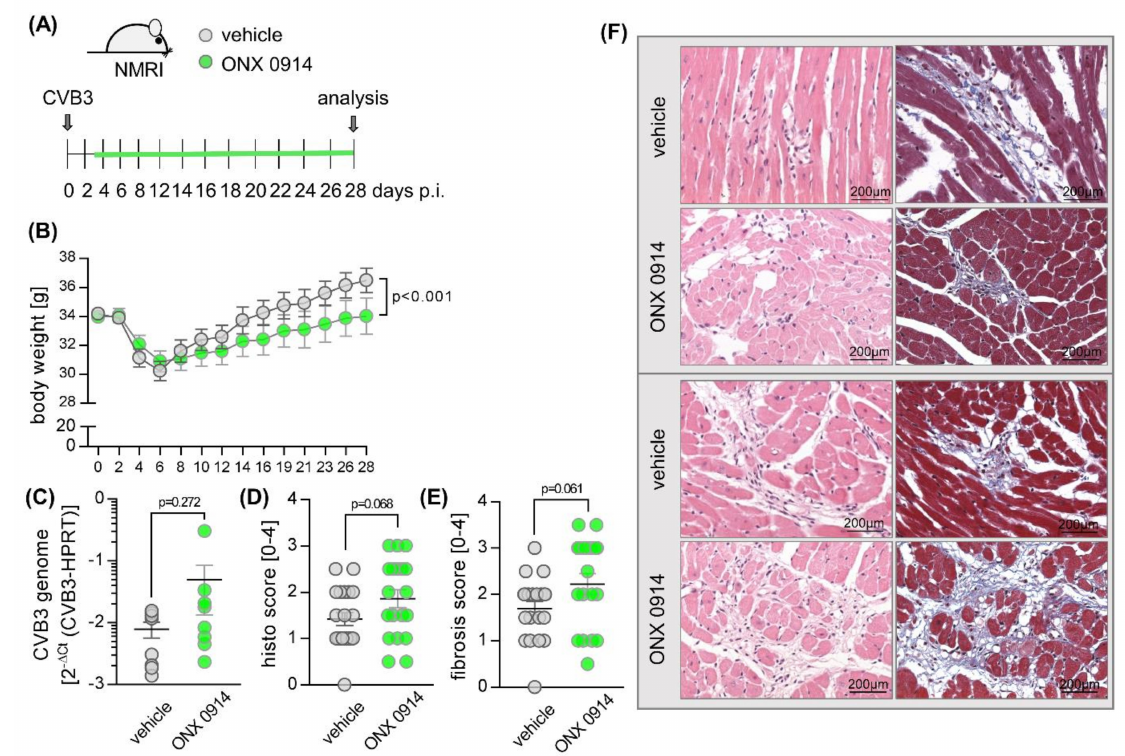
Figure 1. E ff ect of ONX 0914 on the manifestation of chronic viral myocarditis in NMRI mice. ( A ) Mice were inoculated with 5 × 10 5 pfu of Coxsackievirus B3 strain 31-1-93. Between days 3 and 8, mice were treated with ONX 0914 (5–10 mg / kg) or vehicle (Captisol) daily—thereafter treatment continued three times per week until day 28 (vehicle n = 20; ONX 0914 n = 20). ( B ) Body weight was monitored as indicated and analyzed using two-way ANOVA. ( C ) Mice were sacrificed after 28 days. RNA was extracted from heart tissue and Coxsackievirus B3 (CVB3) genome expression was determined by quantitative PCR. Para ffi n-embedded, hematoxylin-eosin ( D ) and Masson’s trichrome-stained cardiac tissue ( E ) was taken for histological scoring of cardiac injury and inflammation. ( F ) Two representative images (upper panel from the group treated with 5–7 mg / kg bodyweight ONX 0914; lower panel from the group treated with 10 mg / kg bodyweight ONX 0914) are shown for each treatment group. Data are mean ± SEM and analyzed by unpaired t -tests. p -values are indicated in each